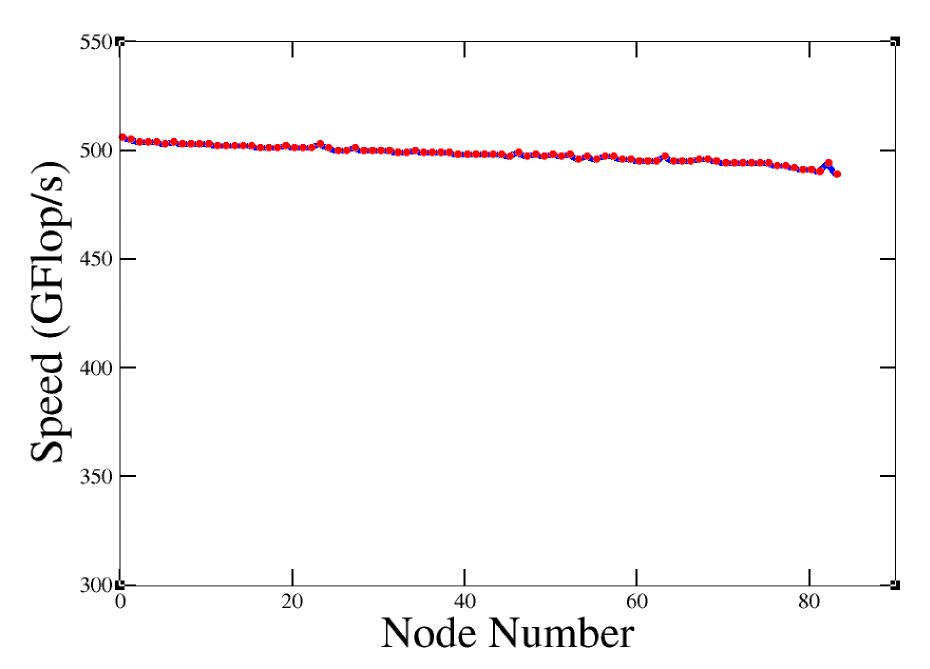
Figure 15. Performance of the nodes after the